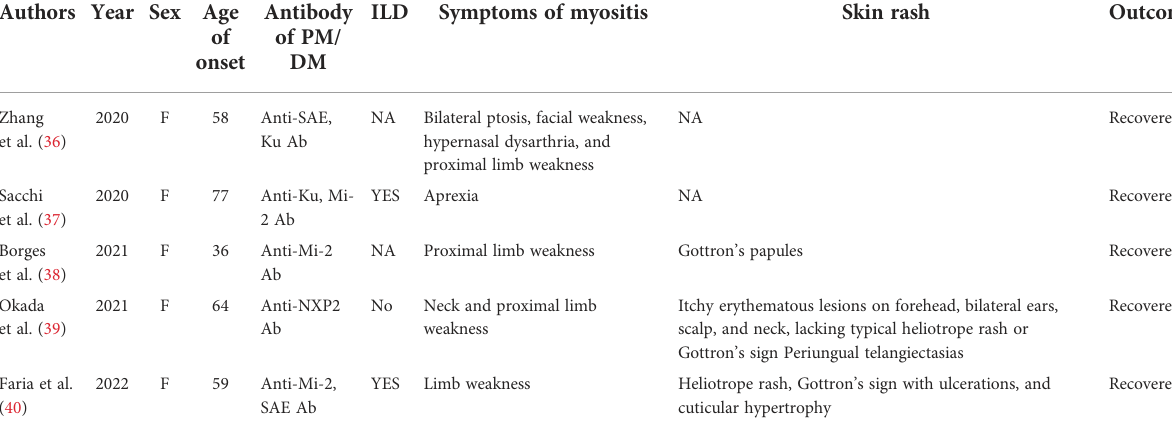
TABLE 1 Complicated cases of COVID-19 and myositis with MSAs excluding anti-MDA5 Ab. Authors Year Sex Age